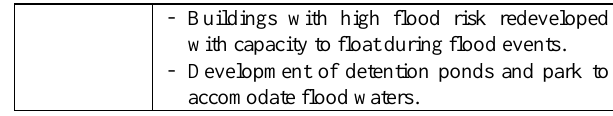
Table 6: Three Scenarios for Booker Bay.